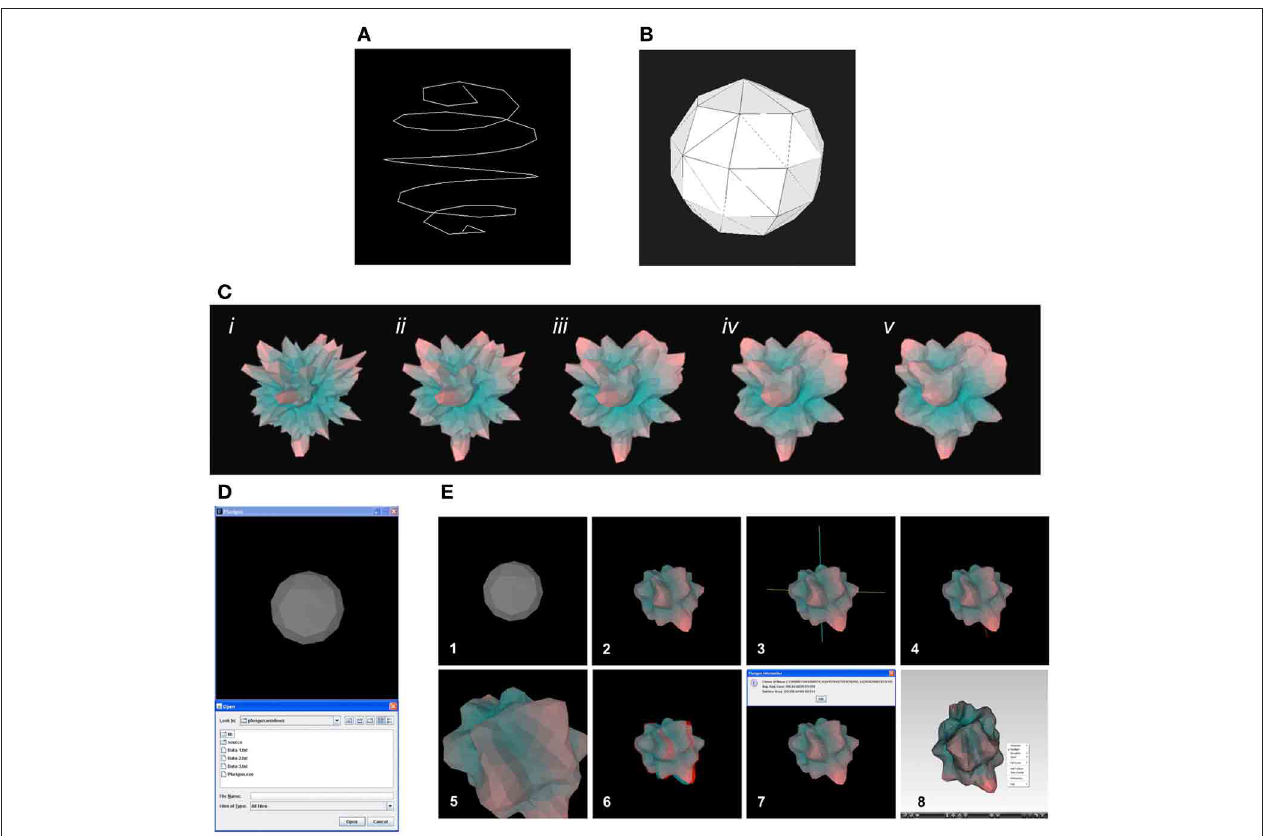
FIGURE 1 | Generation of Plurigon structure and its general manipulation. (A) Initial Plurigon backbone creation. An illustration of vertex placement through spiral tracing. A set of 50 points was placed on the sphere at approximately equal distances from each other. (B) Plurigon polygonal basic structure. Convex hull generated from the vertices shown in (A) . This is the completed version of the Plurigon prototype; radial distance to the core remains constant for all vertices. (C) Laplacian smoothing in progress. Data was taken from a subset of gene expression values from murine genomic expression data. Iterations shown are i , ii , iii , iv , and v , afterwards, the movement of points becomes negligible, so iteration is stopped. (D) Initial Plurigon interface. The basic start-up Plurigon is depicted in an image window. (E) Simple and advanced Plurigon operations. Pressing “o” initiates the ability to choose a specific file to be depicted (1). Loading and pre-processing of data text file results in the generation of the basic color-coded Plurigon (2). Rotation of the Plurigon in all three dimensions is achieved using the up/down and left/right cursor keys. Addition of any other visualization features onto the